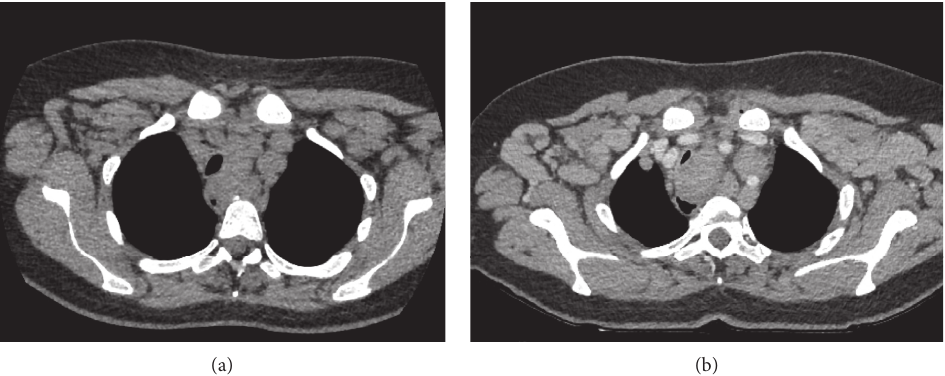
Figure 1: Computed tomography of the chest showing the rapidly expanding mediastinal lymphadenopathy. The trachea was compressed with the narrow diameter of < 1cm. (a) Pretreatment. (b) Day 14 following commencement of